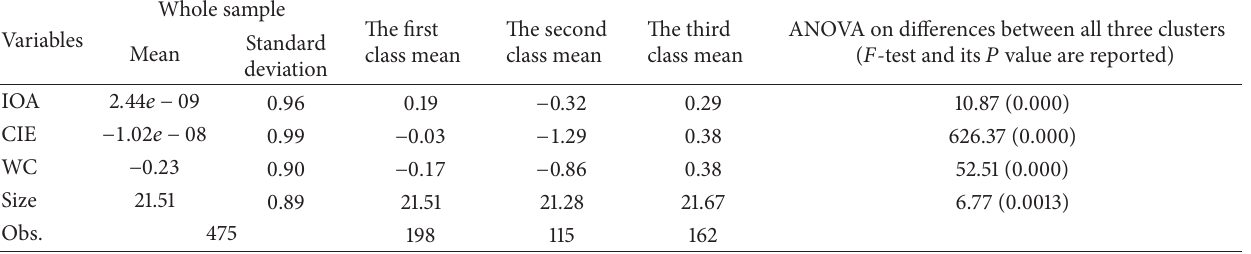
Table 3: Factors in different classes.